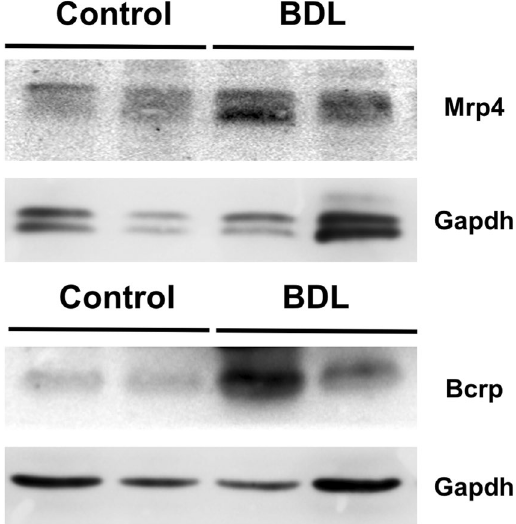
Figure 6. Representative western blot analysis of Mrp4 and Bcrp in mammary gland lysates obtained from two control and two bile duct-ligated (BDL) rats on day 10 ± 1 post-partum . Detection of GAPDH served as a loading